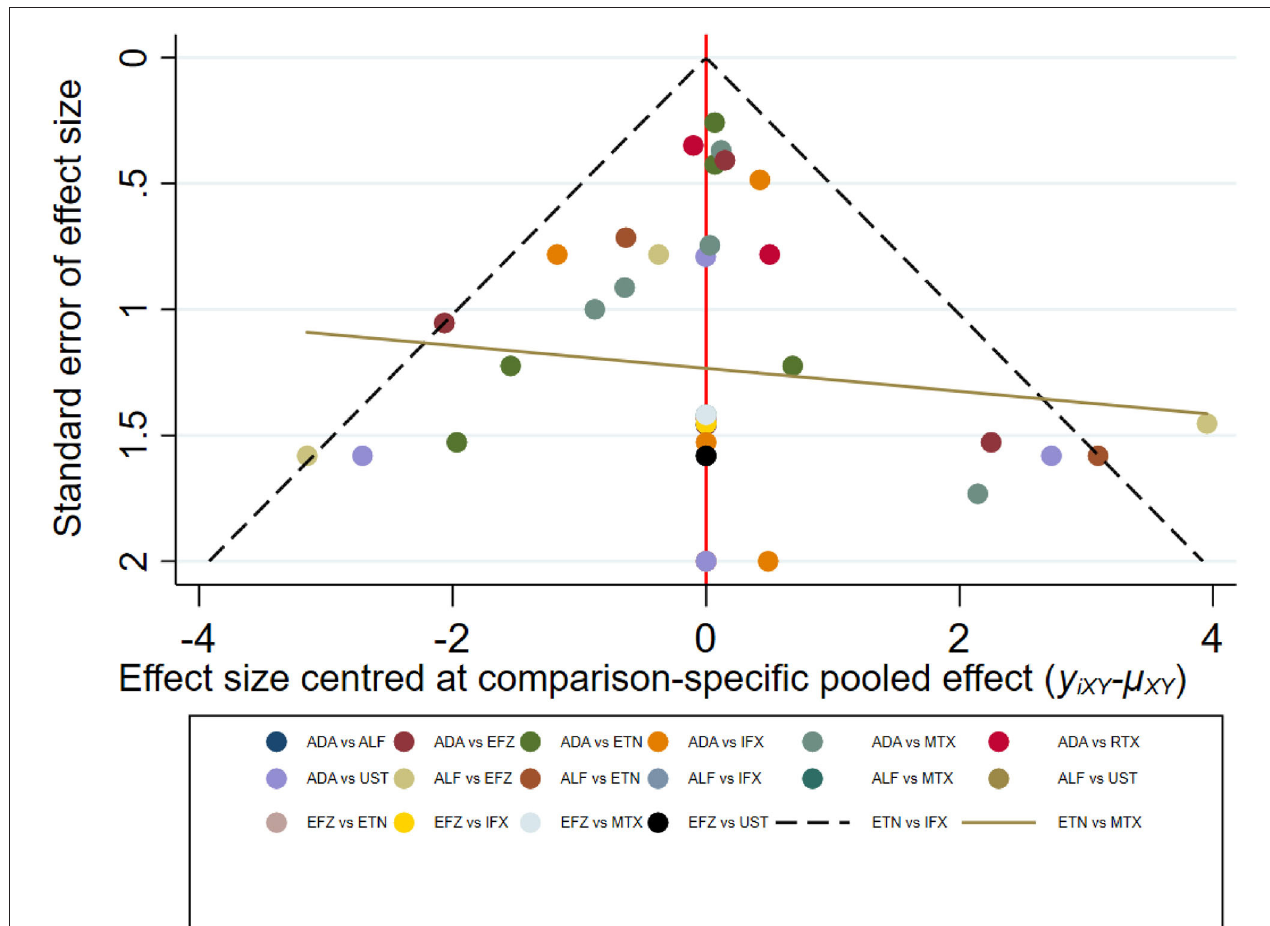
FIGURE 4 | Funnel plot of network